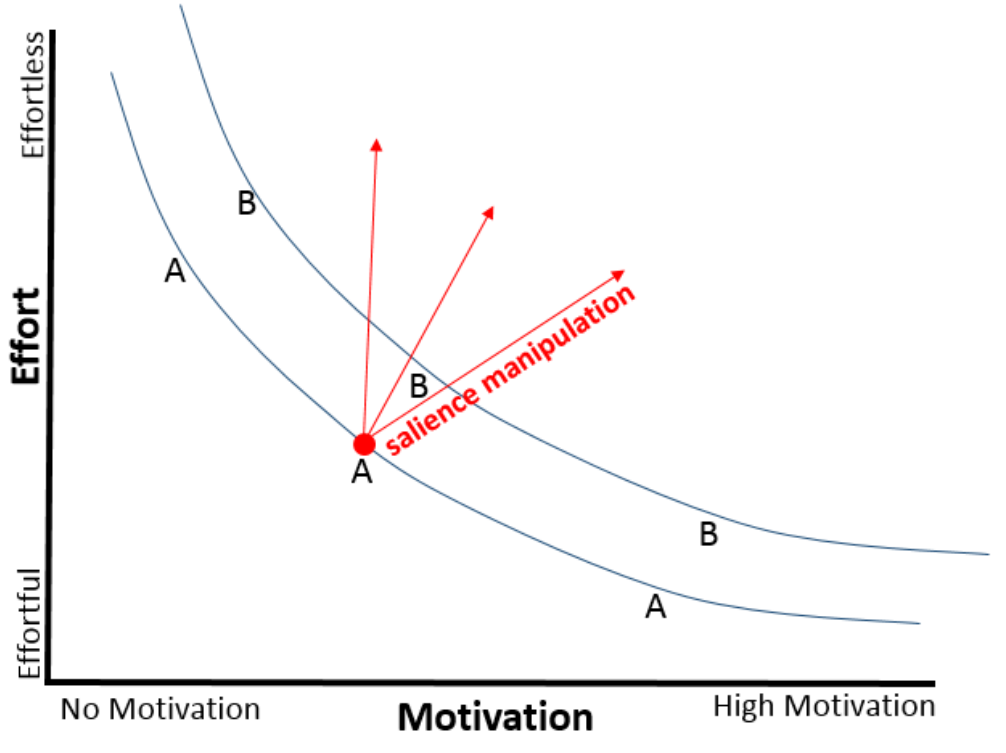
Figure 2. The probability of an activity occurring in the face of competition as a function of effort, motivation, and salience. The blue curves are probability